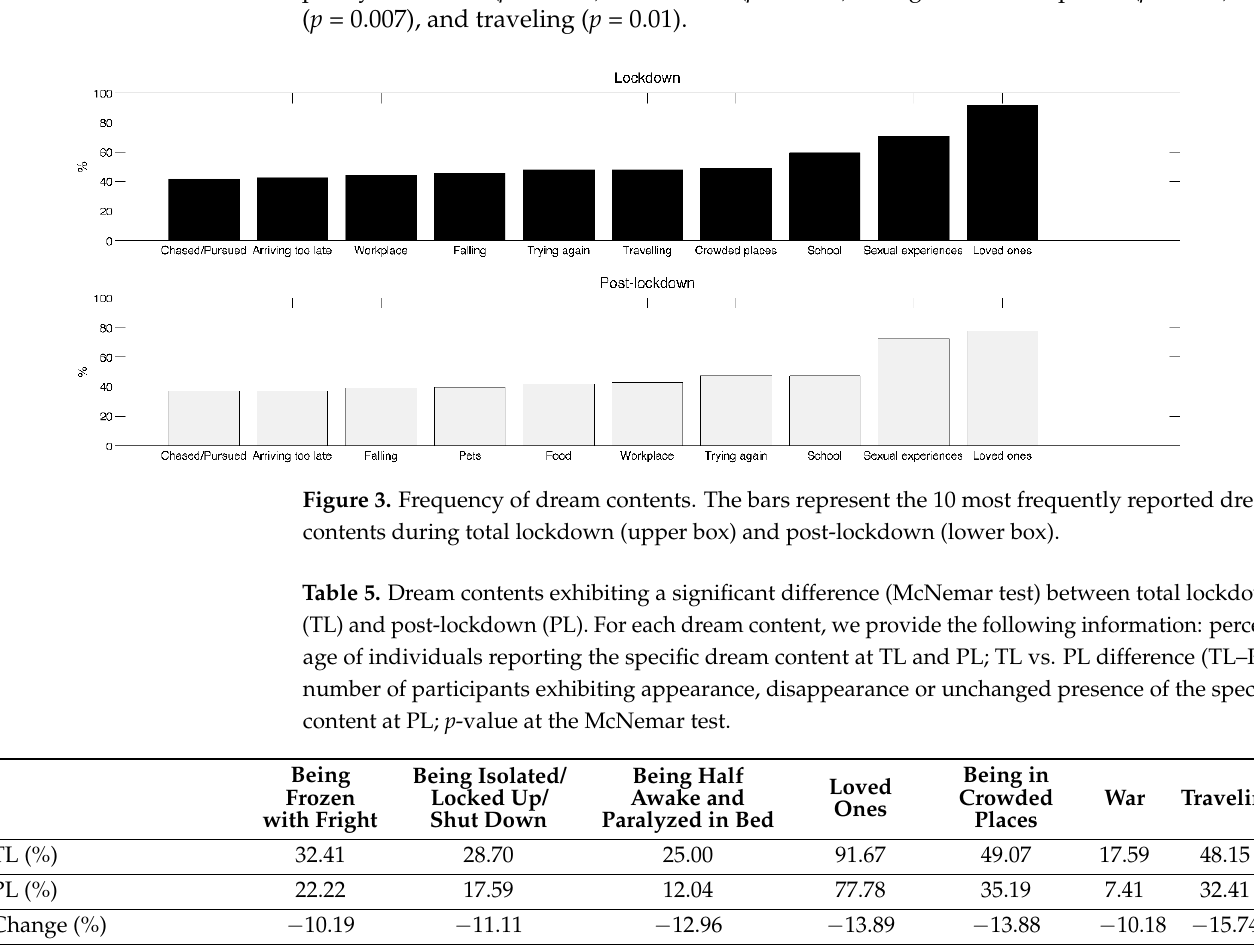
9 of 18 Figure 2. Percentage of each assessed emotion (white bars) reported in dreams during total lock- down (upper box) and post-lockdown (lower box). Black bars represent the overall percentage of positive and negative emotions in each time period.